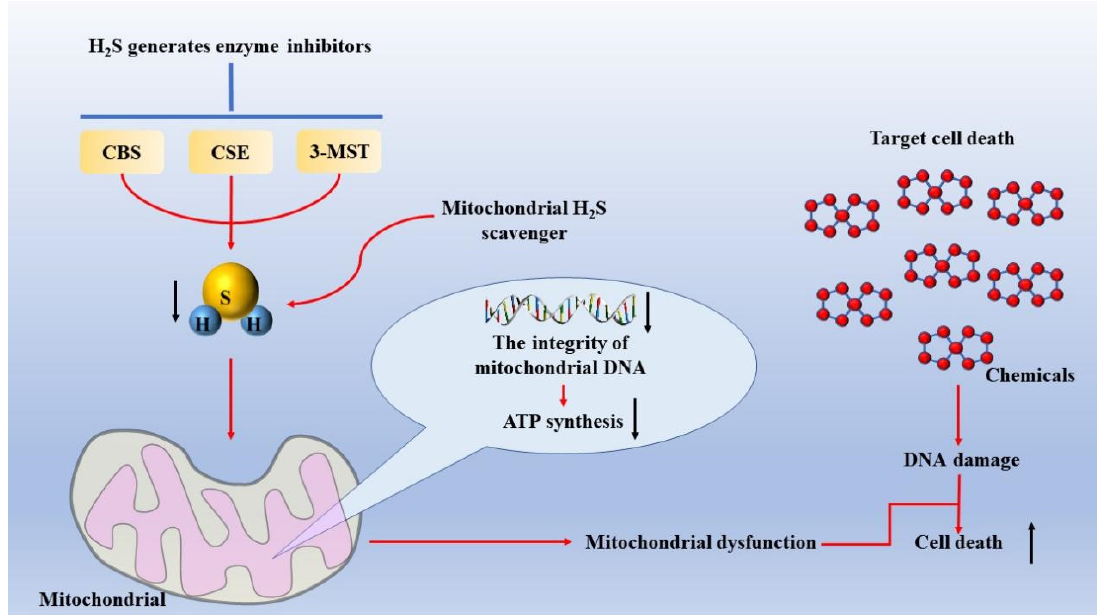
Figure 2. Mechanism of inducing mitochondrial dysfunction in lung adenocarcinoma cells. H ₂ S- generating enzyme inhibitors, such as AOAA, which is commonly used in CBS and CSE, or mito- chondrial H ₂ S scavengers, are used to reduce intracellular H ₂ S levels, thereby inducing mitochon- drial dysfunction and improving the sensitivity of lung adenocarcinoma cells to chemotherapy drugs. Abbreviations: AOAA: aminooxyacetic acid; CBS: cystathionine β -synthase; CSE: cystathi- onine γ -lyase.